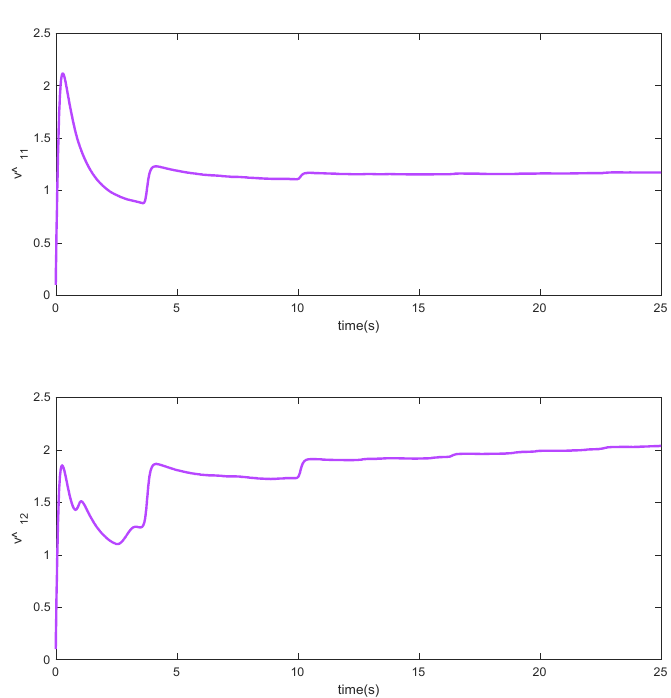
Figure 6. Adaptation laws 𝜈̂ (cid:2869)(cid:2869) , 𝜈̂ (cid:2869)(cid:2870) in Scenario 1.